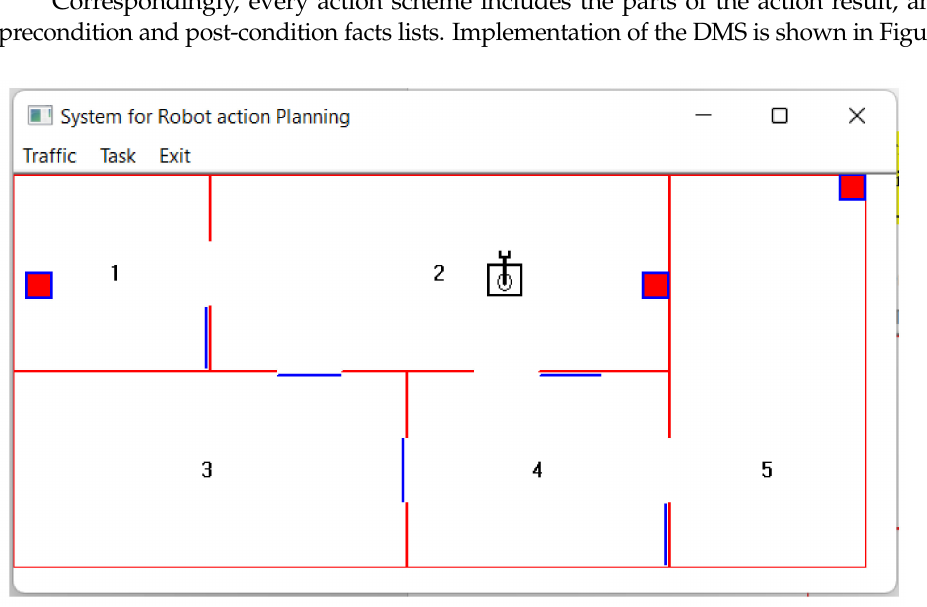
Figure 2. Decision-making system